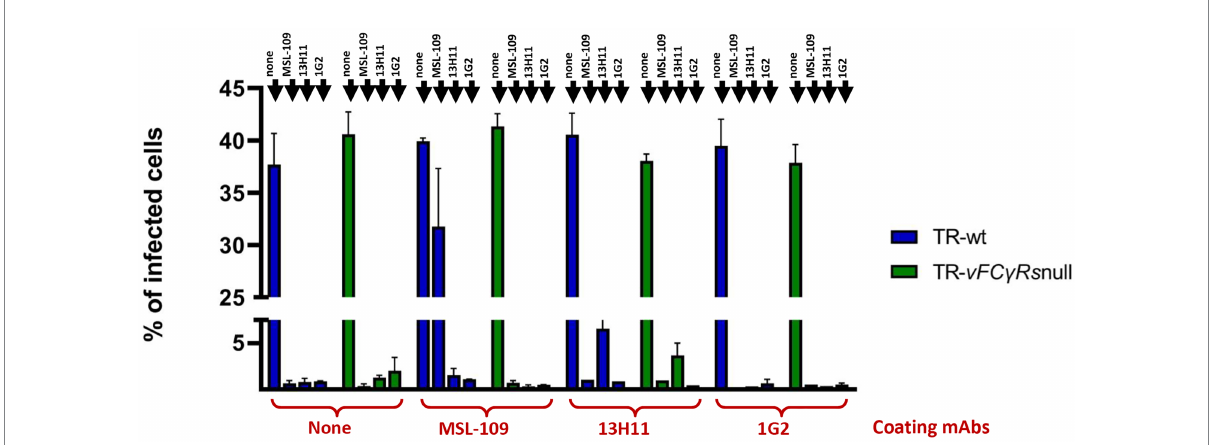
FIGURE 7 Neutralization assays on untreated and mAbs-coated TRvFc γ Rs-null and parental strain. HFF-1 were infected with either TR-wt or TR- vFc γ Rs -null at an MOI of 1 and infection carried on for 48 h before adding 13.2 μ g/ml of the mAb as indicated in the legend. Medium was changed at day 4 p.i. and replaced with fresh medium. At day 6 p.i., culture media were collected, cleared from cellular debris, and viral genomes quantified by Digital PCR. Fresh HFF-1 were infected at MOI 1 with viruses untreated or pre-incubated with the mAb indicated on the x -axis. Antibodies used for neutralization are specified on each bar. Percentage of infected cells was calculated 24 hpi by cytofluorimetry using an anti-CMV 488-conjugated